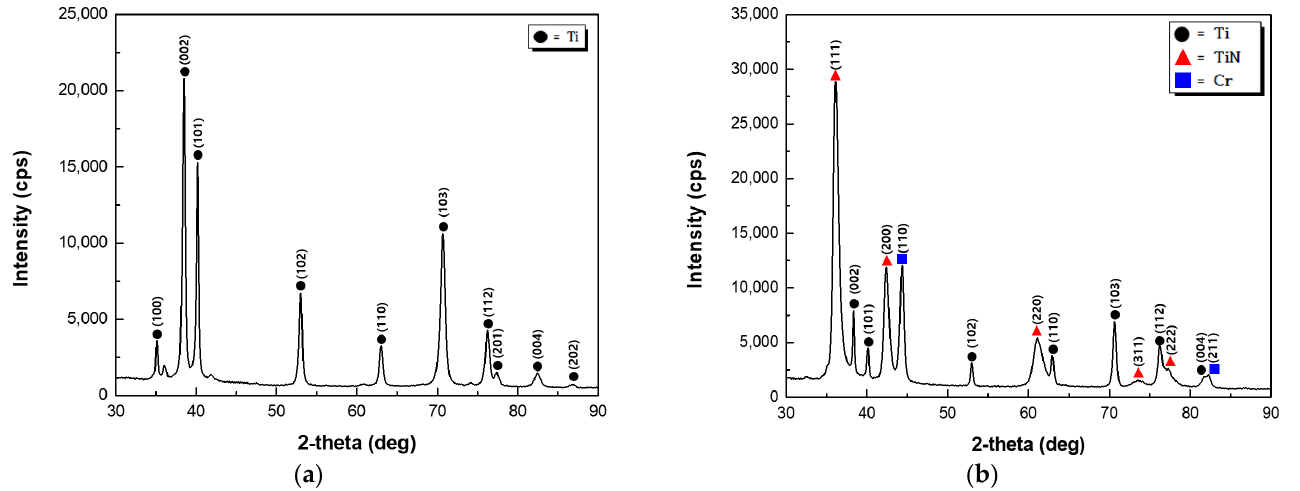
Figure 3. XRD patterns of TiN-coated specimen; ( a ) Ti substrate; ( b ) TiN-coated specimen.